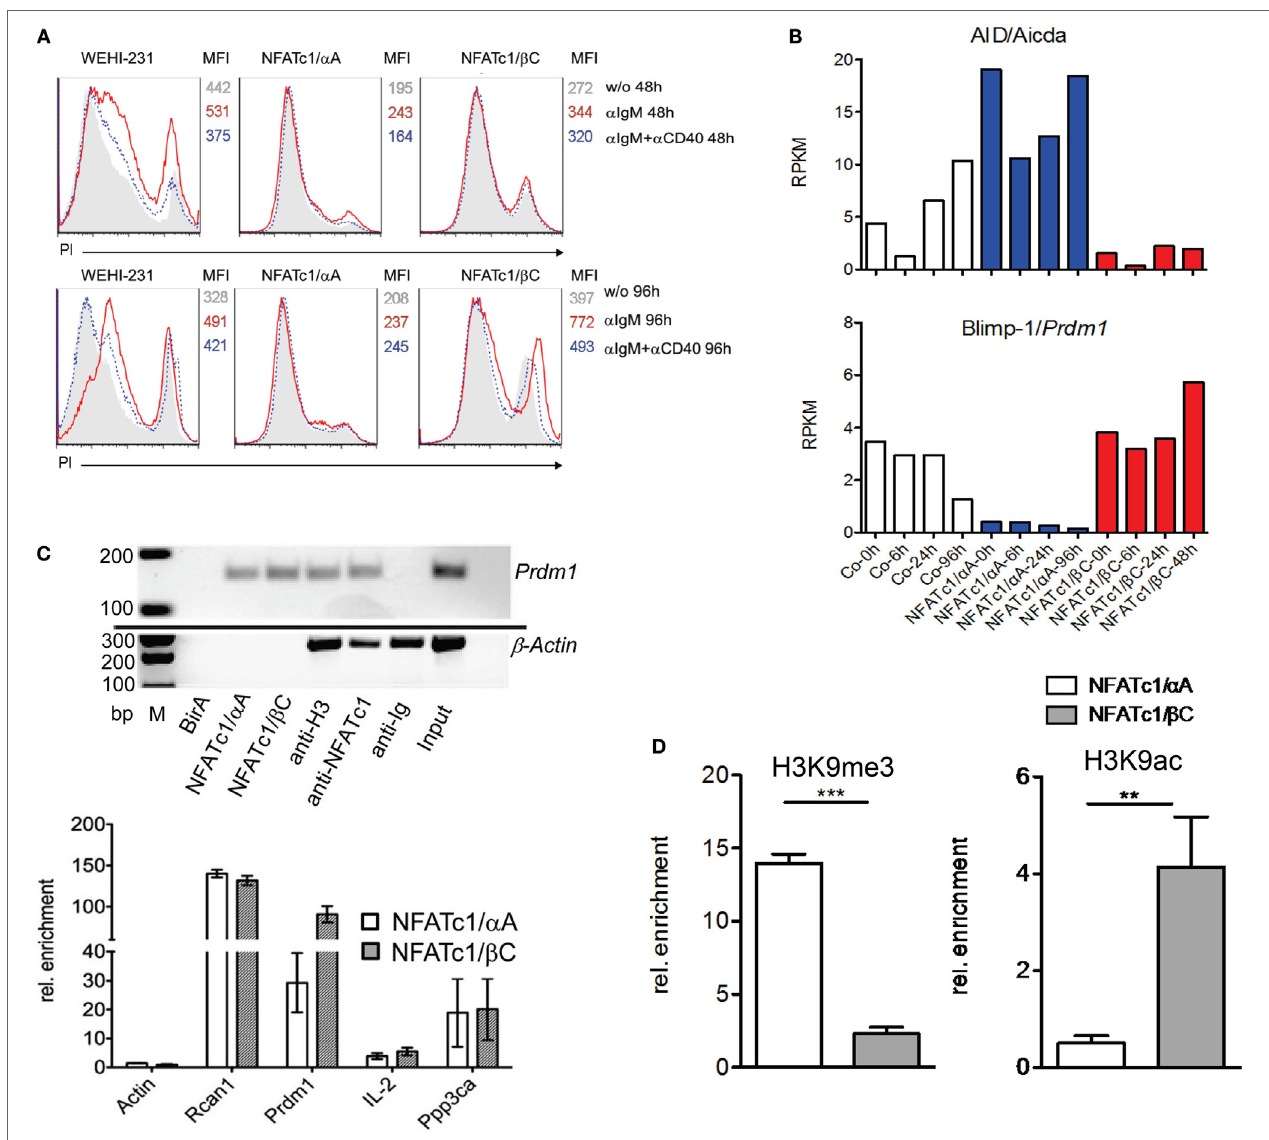
FigUre 3 | Effect of NFATc1/ α A-bio and NFATc1/ β C-bio proteins on cell death and the expression of Aicda and Prdm1 genes in murine WEHI 231 B lymphoma cells. (a) WEHI 231 B cells stably infected with retroviral vectors expressing BirA (WEHI-231), Bir A and NFATc1/ α A-bio (NFATc1/ α A), or BirA and NFATc1/ β C-bio